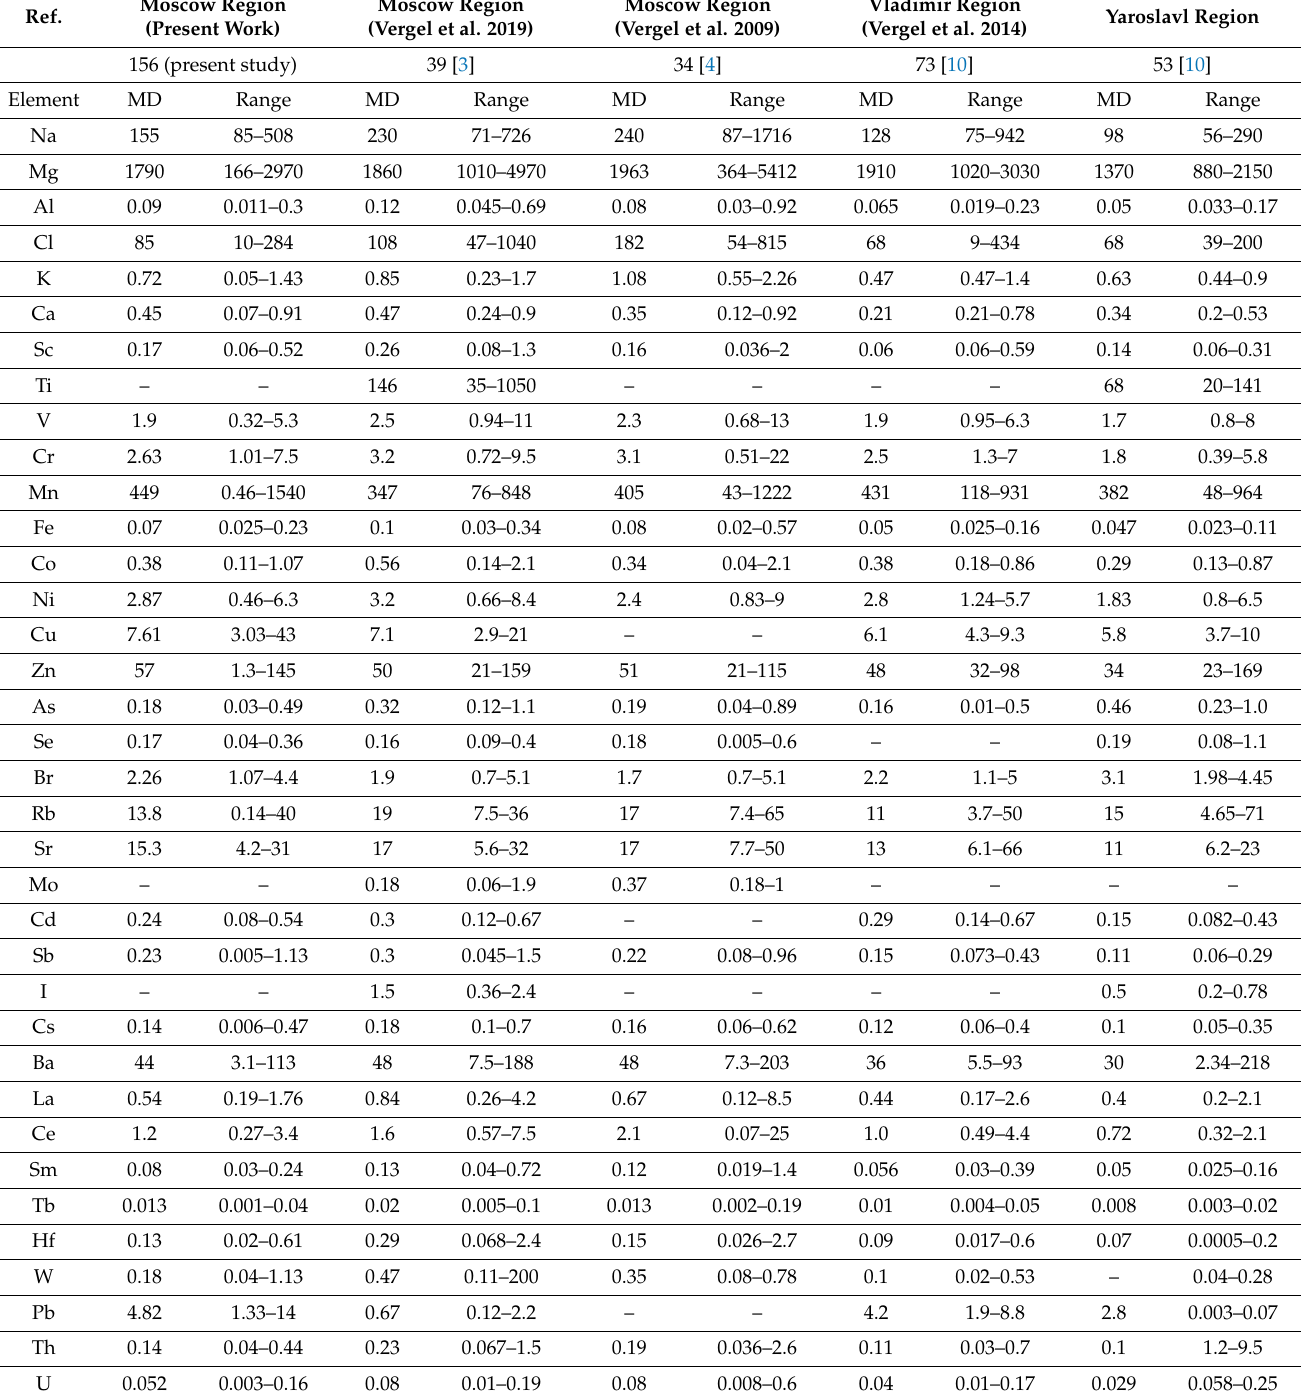
Table 3. A comparison of the content of the elements as obtained in the present study and literature data. All contents expressed in mg/kg except Al, K, Ca, and Fe, whose contents are expressed in %